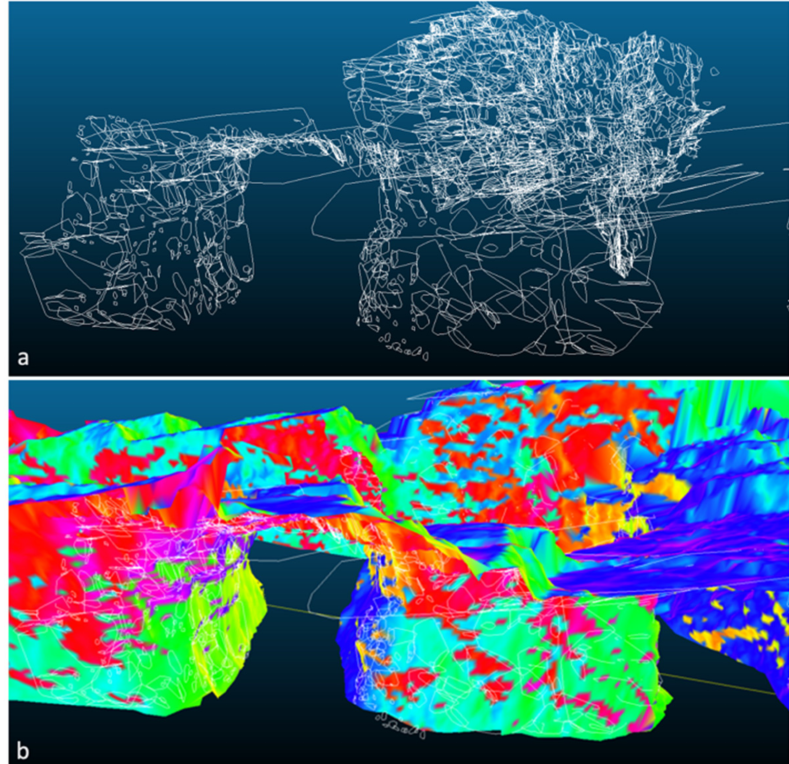
Figure 10. Extraction of discontinuity planes: step 3. ( a ) Union of the extracted polygons for the different scanning positions and eliminate redundancies. ( b ) Union of the extracted polygons for the different scanning positions and elimination of redundancies. The polygons are projected onto the coloured 3D model according to the local immersion direction.